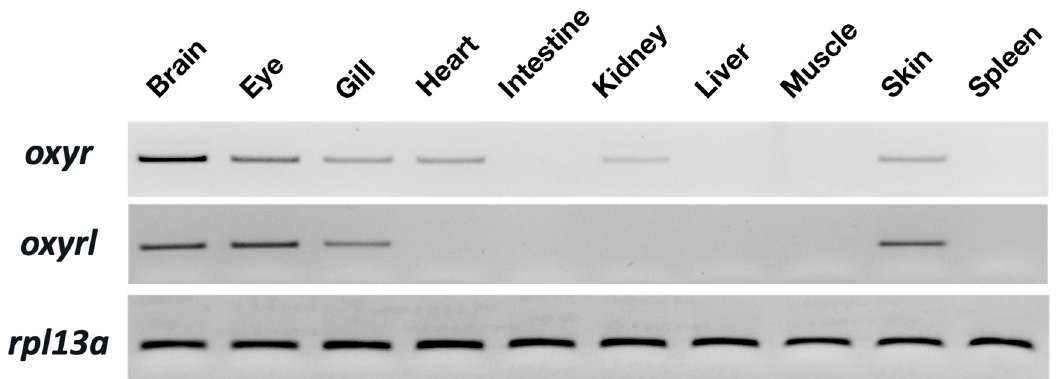
Figure 1. Distribution of oxyr and oxyrl in different tissues of adult zebrafish. The mRNA expression of target genes was analyzed through semi-quantitative PCR; rpl13a was used as an internal control to confirm the cDNA quality of different tissues.